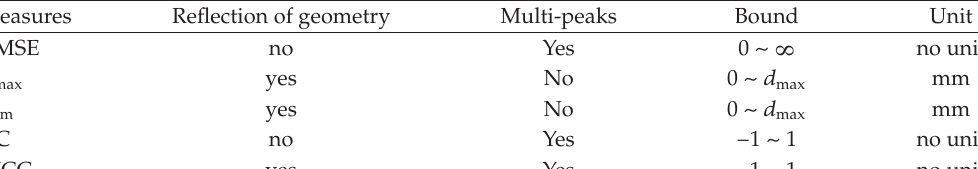
Table 1: The merits and demerits of measures.